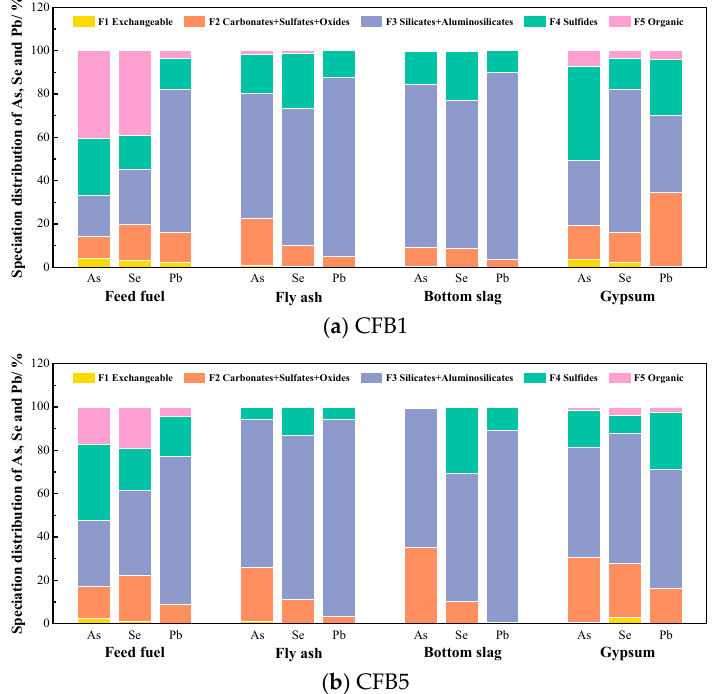
Figure 9. Speciation distribution of As, Se and Pb in feed fuel and combustion by-products of CFB1 and CFB5.